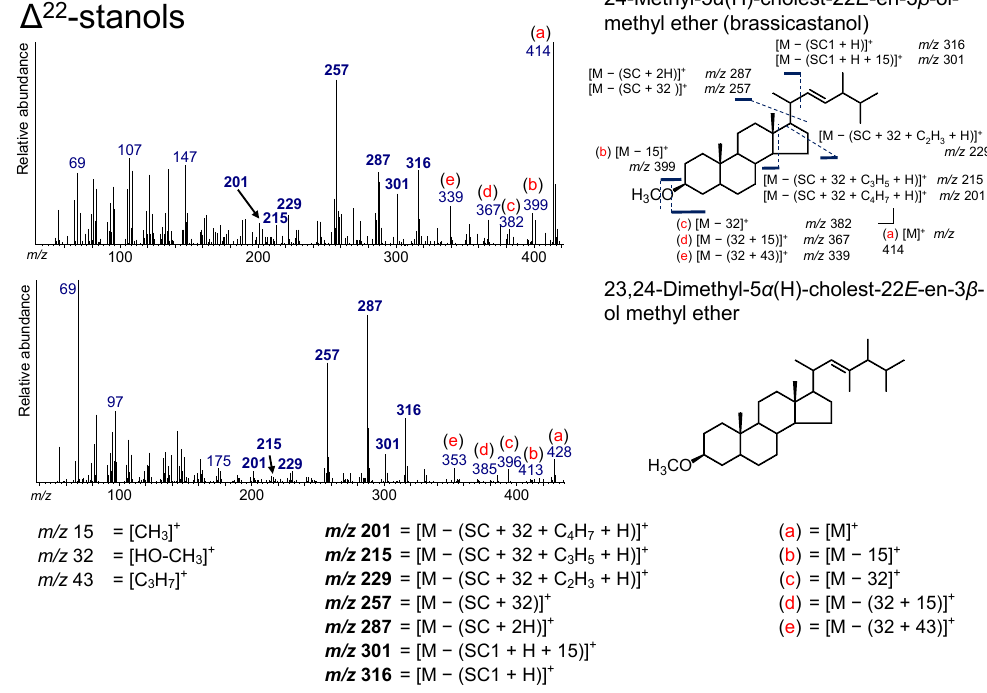
Figure 9. Electron ionization mass spectrum of ∆ 22 -stanol. Bold numbers indicate an ion that accompanies the cleavage of the side chain. ( a )–( e ) Ions that are not accompanied by the loss of the side chain or other